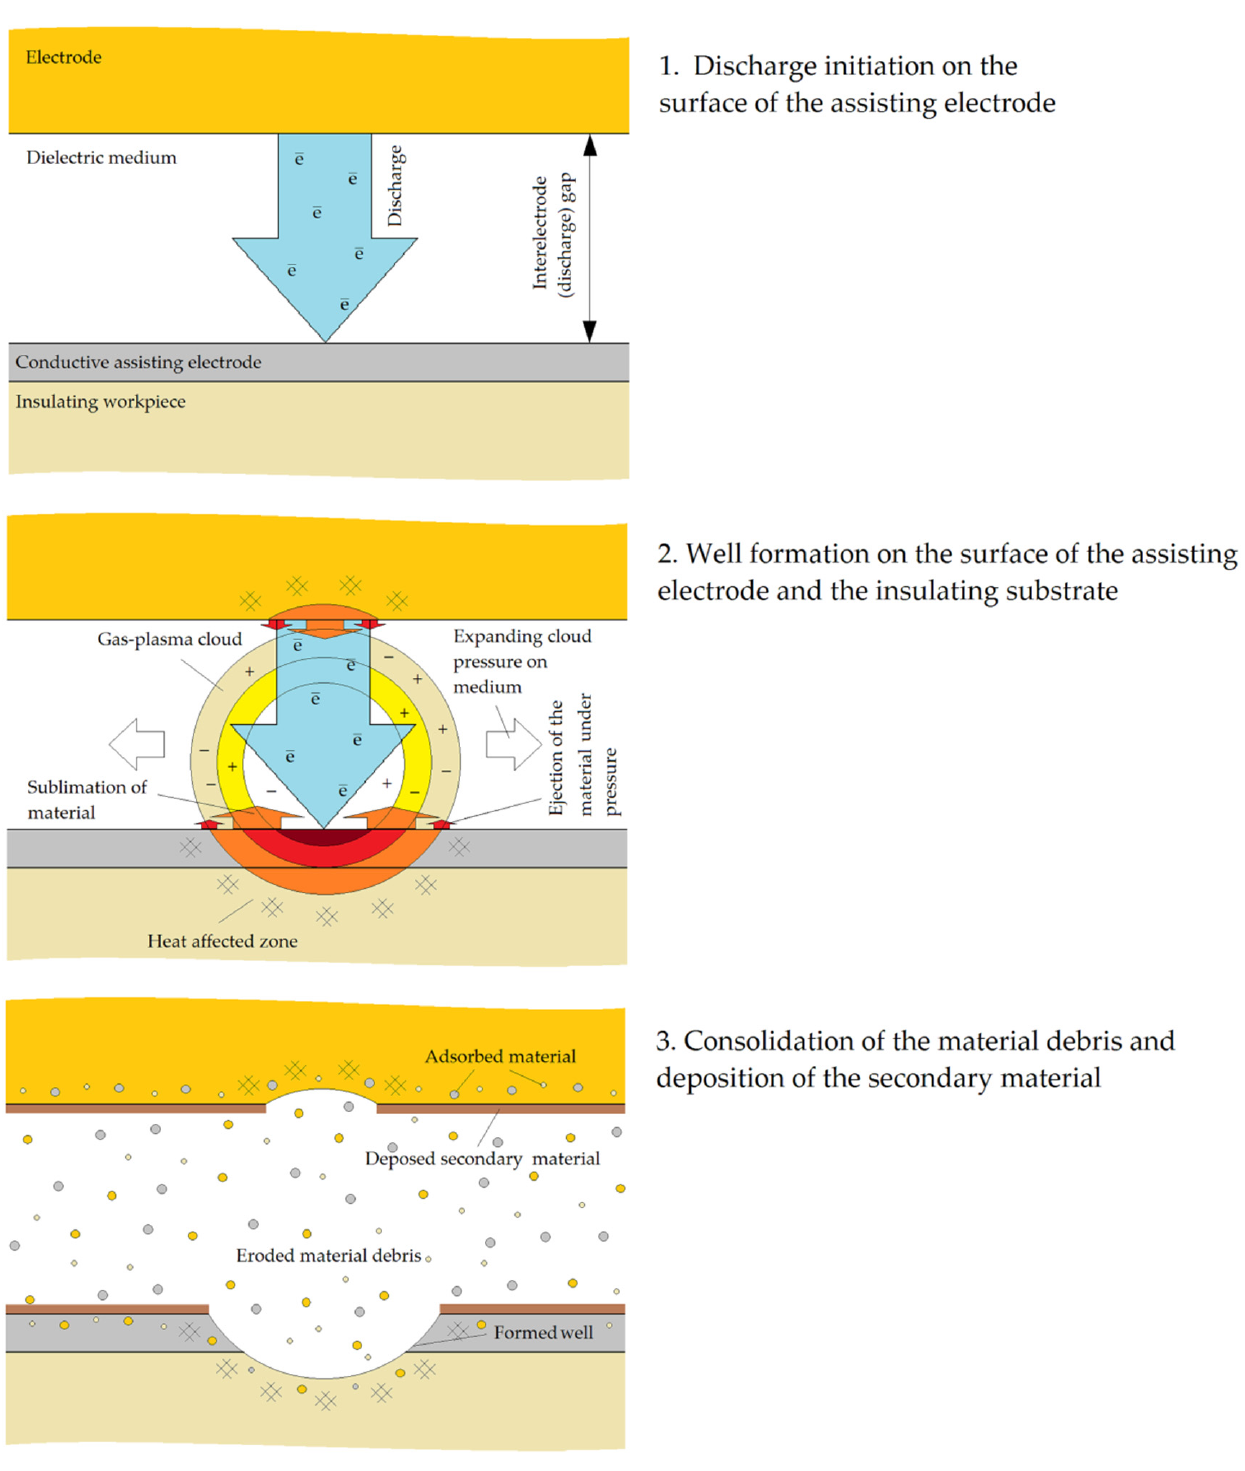
Figure 1. Principle of the electrical erosion of insulating material using assisting electrode tech- nique. Table 2. Reported types of auxiliary electrodes.